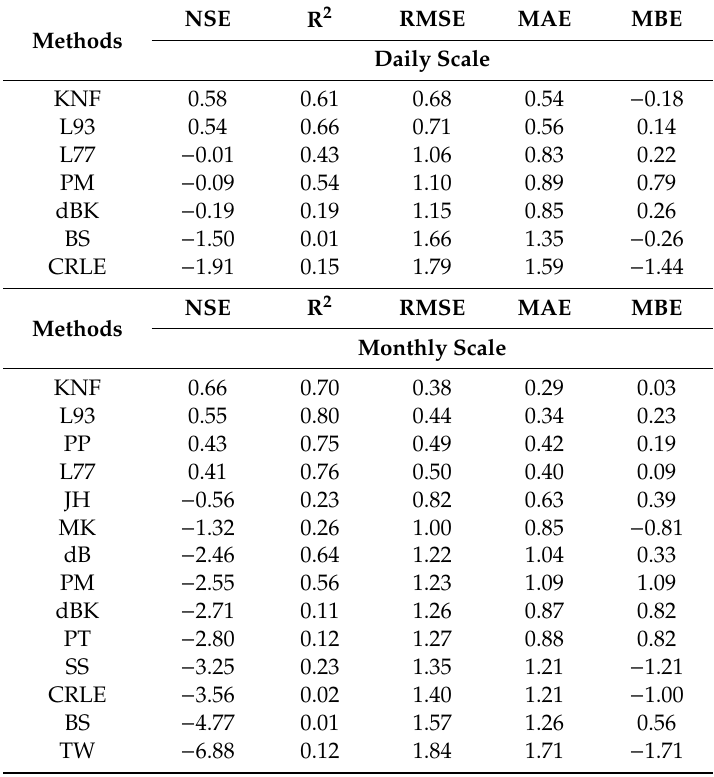
Table 2. Performance criteria of the evaporation estimation